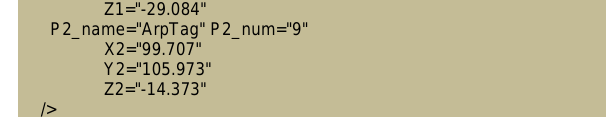
Figure 9. One of the five distance constraint after final bundle adjustment.